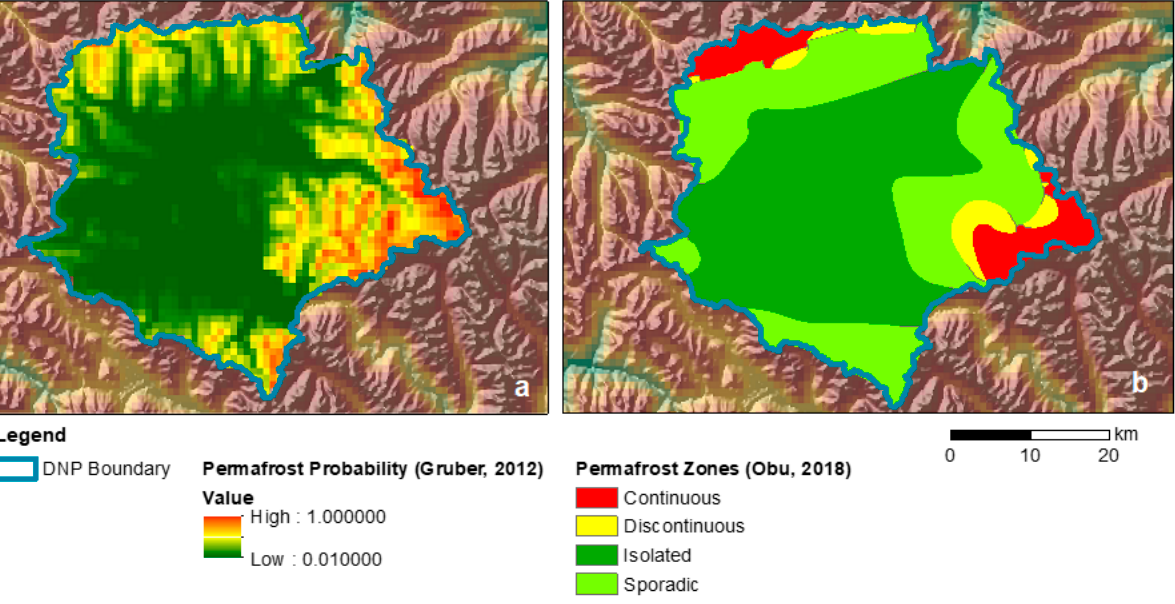
Figure 4. Maps of the permafrost probability ( a ), and permafrost zones ( b ), adapted the freely available global models [9,15].